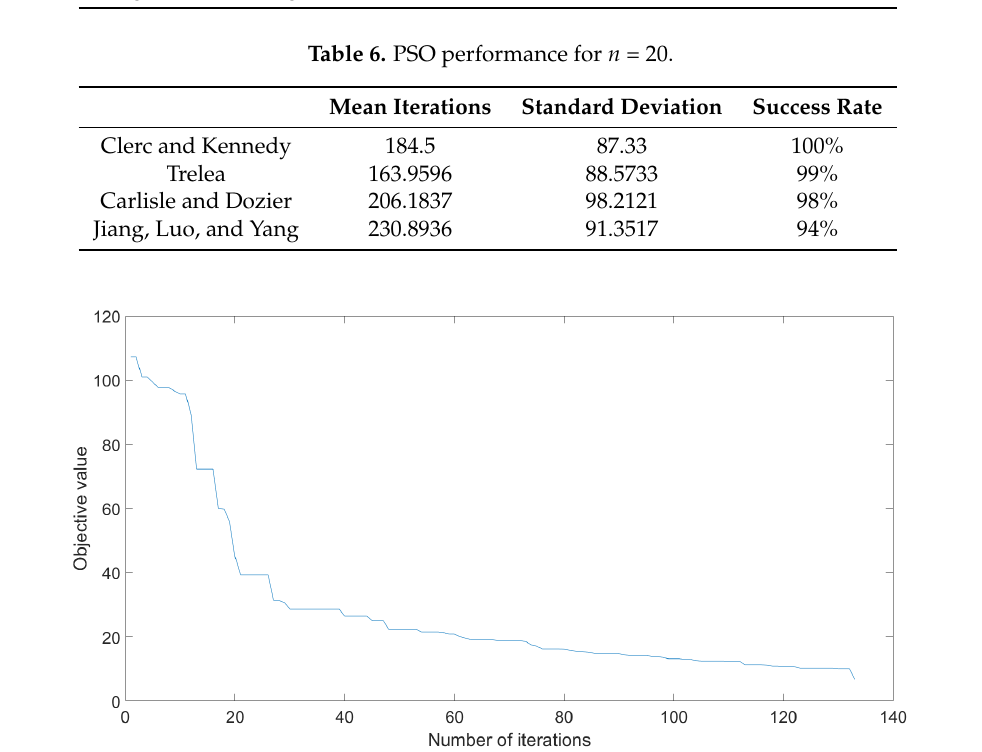
Figure 10. Objective value evolution for